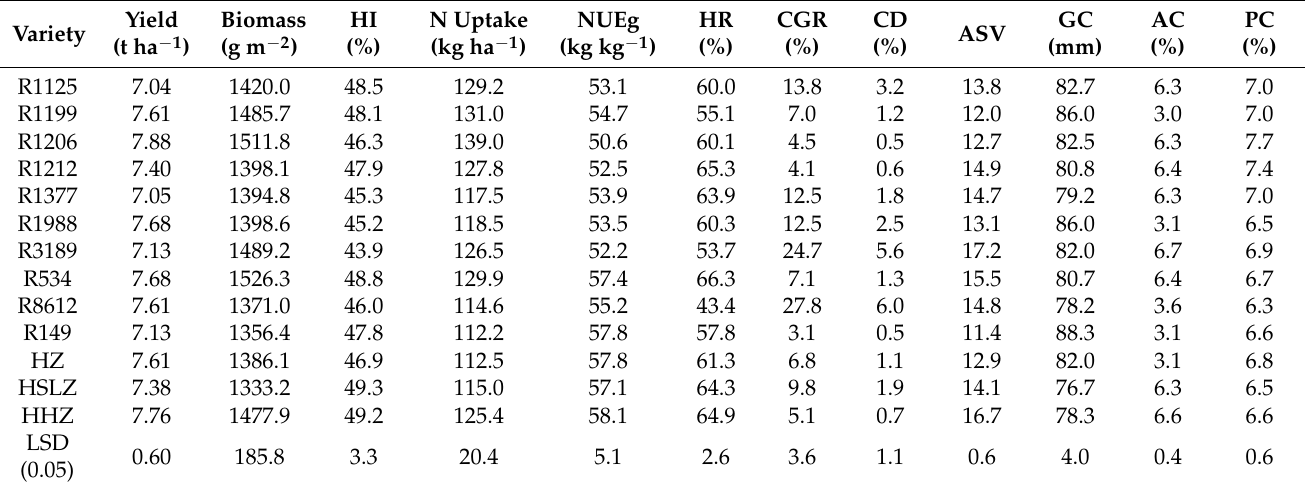
Table 4. Traits related with grain yield, nitrogen use efficiency and grain quality for the male parent